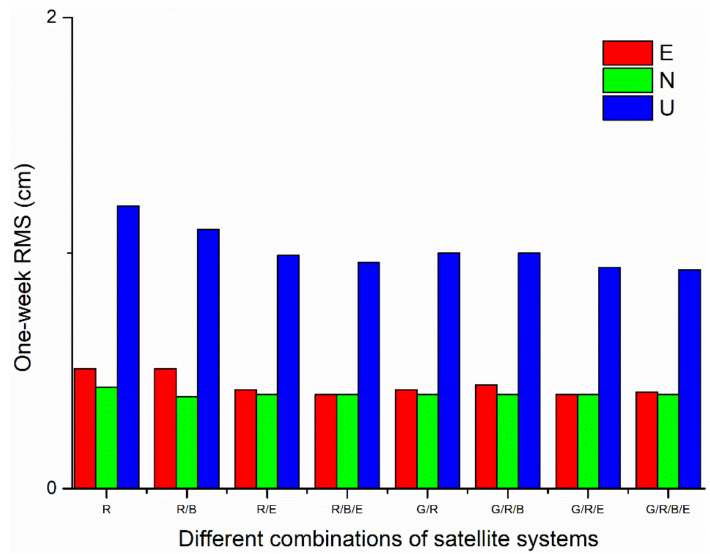
Figure 4. Positioning accuracy of different combined solutions for the LF model in static mode.